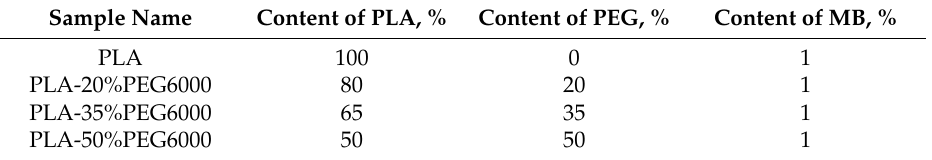
Table 1. Composition of Polylactide (PLA)/polyethylene glycol (PEG)/methylene blue (MB).